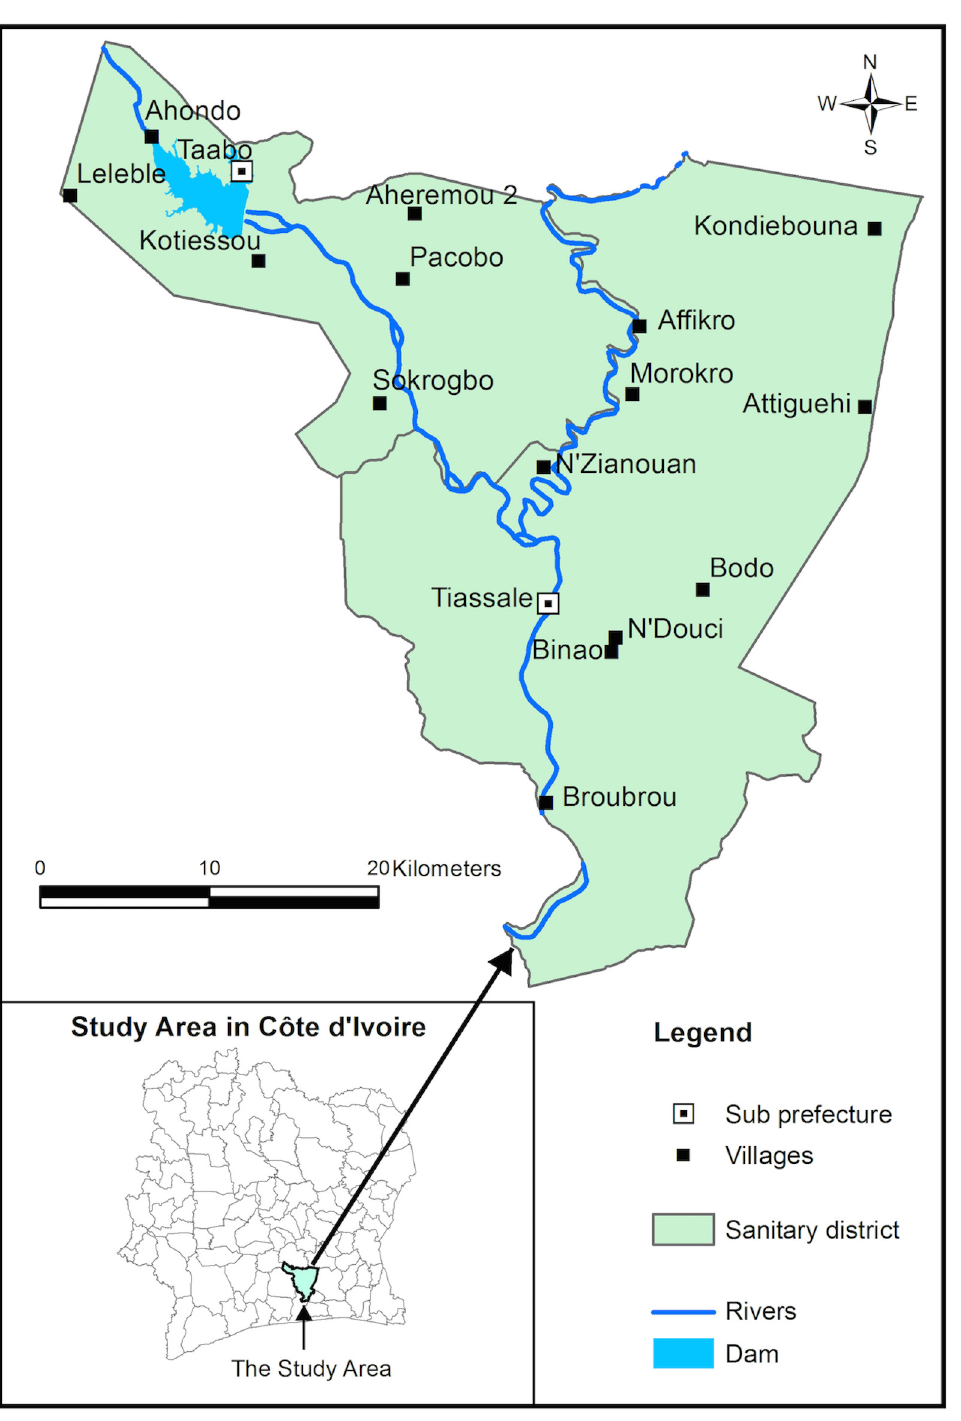
Fig 1. Map of the district of Tiassalé, in south Côte d ’ Ivoire.